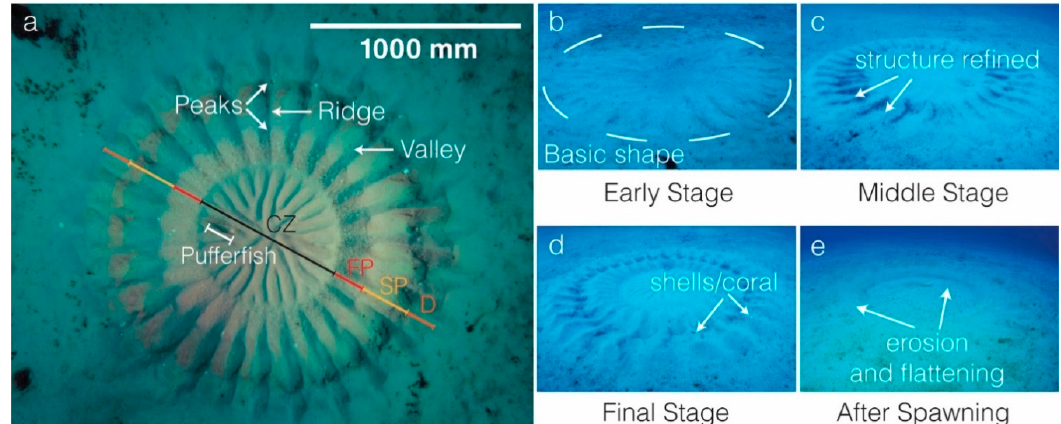
Figure 1. Basic structure of pufferfish nests and different stages of nest construction as observed by Kawase et al. [4] during June and July of 2012. ( a ) Nest is characterised by the radially aligned pairs of ridges and valleys. Each ridge consists of two prominent peaks. Top view image of the nest was later used for digital measurements of each nest zone. Black—Central Zone (CZ), Red—First Peak (FP), Yellow—Second Peak (SP), Orange—Nest Diameter (D); ( b ) Basic circular shape is excavated by the male pufferfish; (c) Refinement of structural features and expansion of the central zone; (d) Completion of the structure, at the end of which spawning takes place. Male is observed placing shell and coral fragments on the ridge peaks during this stage; (e) Structure is not maintained post-mating and it slowly erode and flattens. ( a ) Image modified from [7]; ( b – e) Images modified from [4].